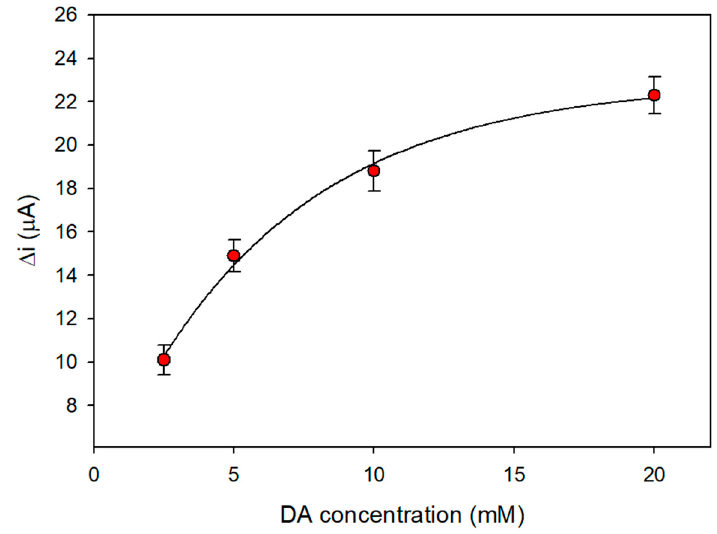
Figure 3. Influence of DA concentration in the deposition solution on MIP performances. Each value represents the mean of triplicate measurements; the error bars represent the relevant standard deviations. MIP deposition was carried out by scanning the potential in the range - 0.1/0.9 V vs SCE for 30 cycles at a scan rate of 100 mV/s, employing a 5 mM monomer solution in acetate buffer at pH 5.0.